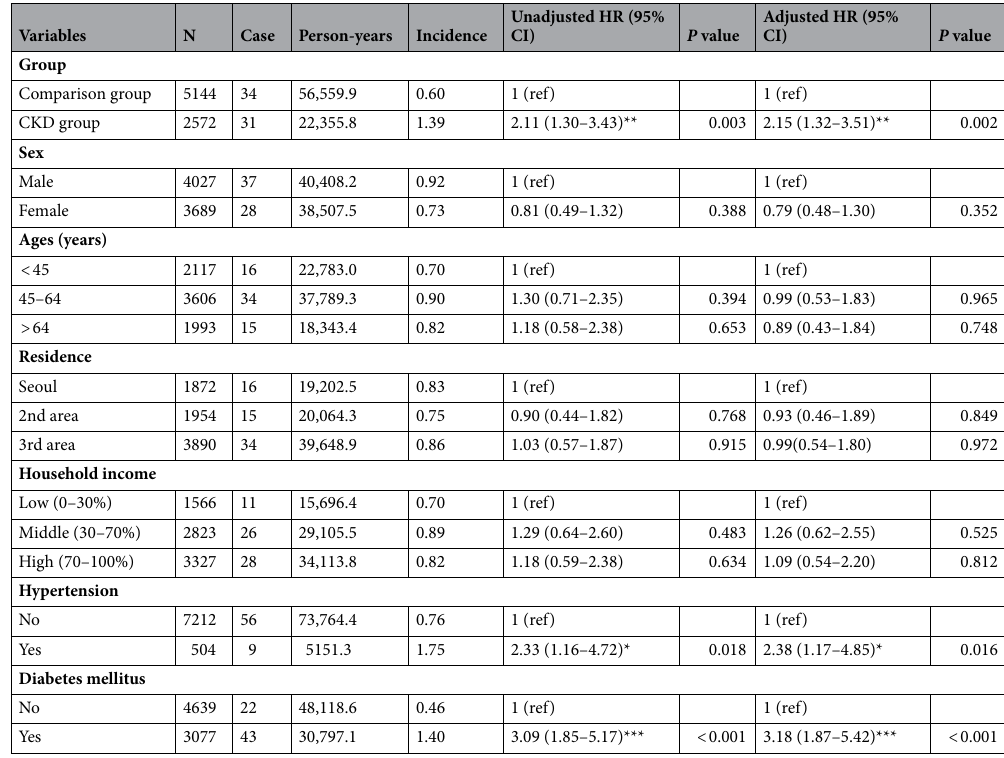
Table 2. Incidence per 1000 person-years and hazards ratio (95% confidence interval) of sudden sensorineural hearing loss. CKD, Chronic kidney disease; SSNHL, Sudden sensorineural hearing loss; HR, Hazard ratio; CI, Confidence interval. * P < 0.05, ** P < 0.010, and *** P <